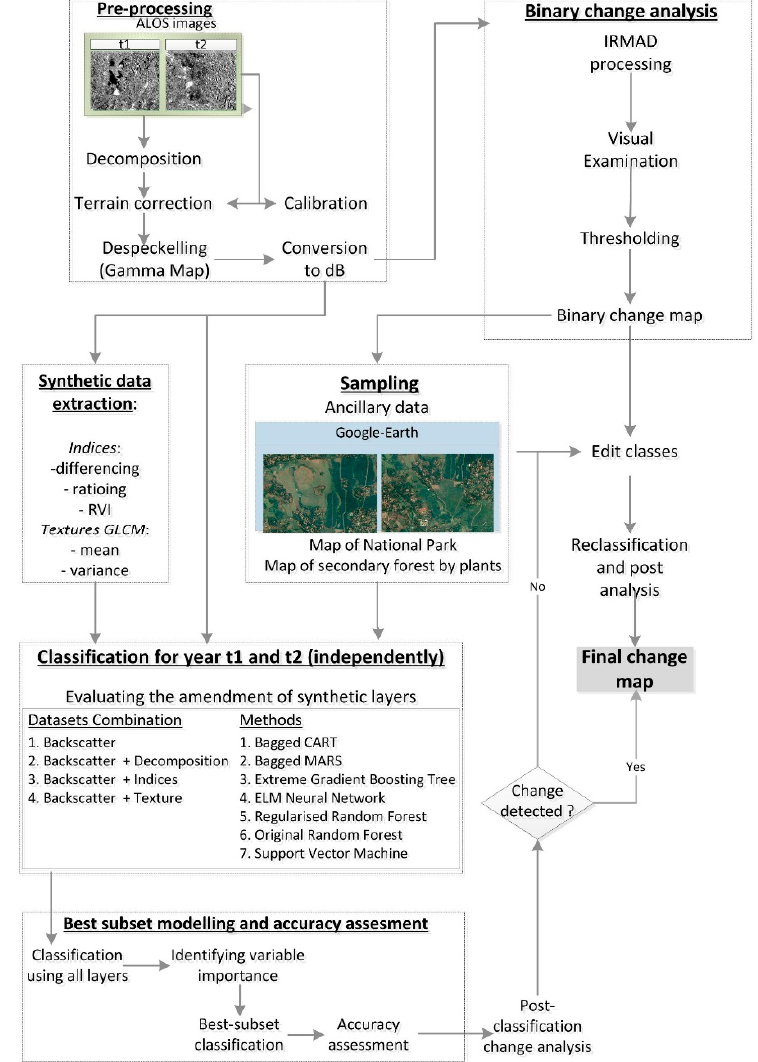
Figure 2. The workflow of identifying subtle changes at the Halimun Salak National Park